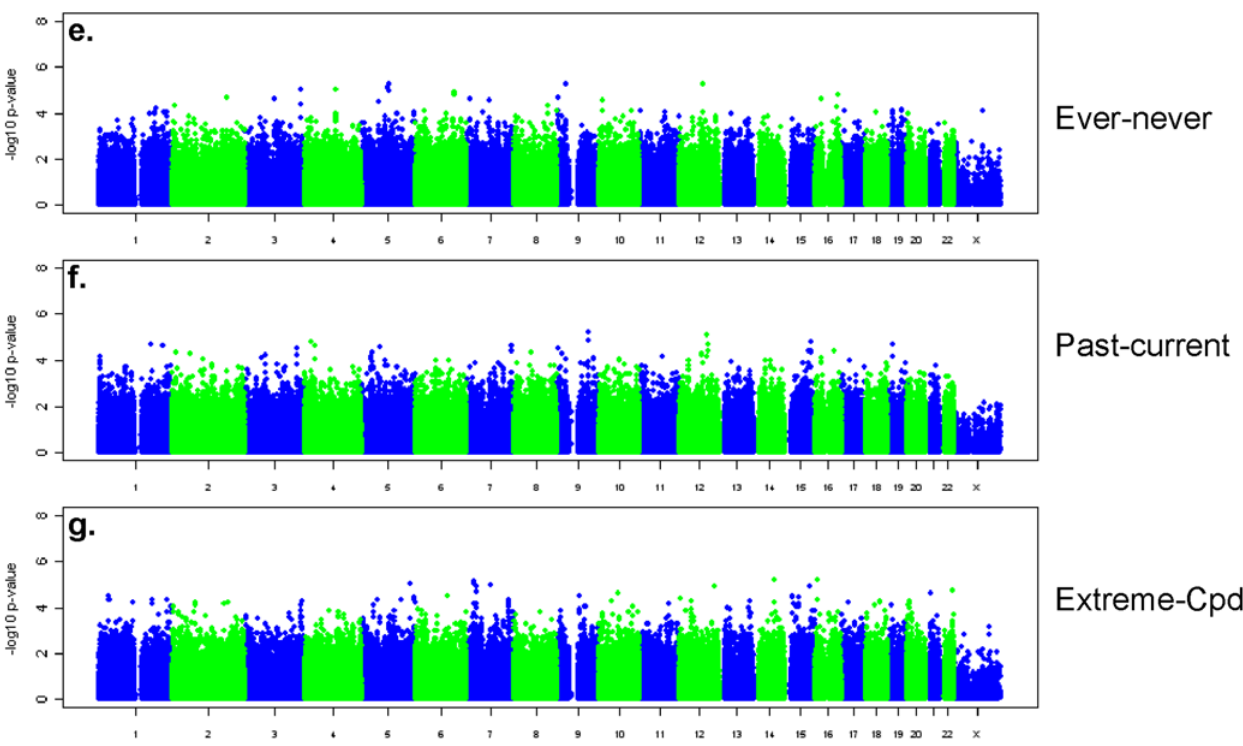
Figure 2. 2 log 10 p-values for association with seven continuous (Figure 1) and categorical (Figure 2) smoking behaviors. P-values are based on the combined evidence for association from both PLCO and NHS.